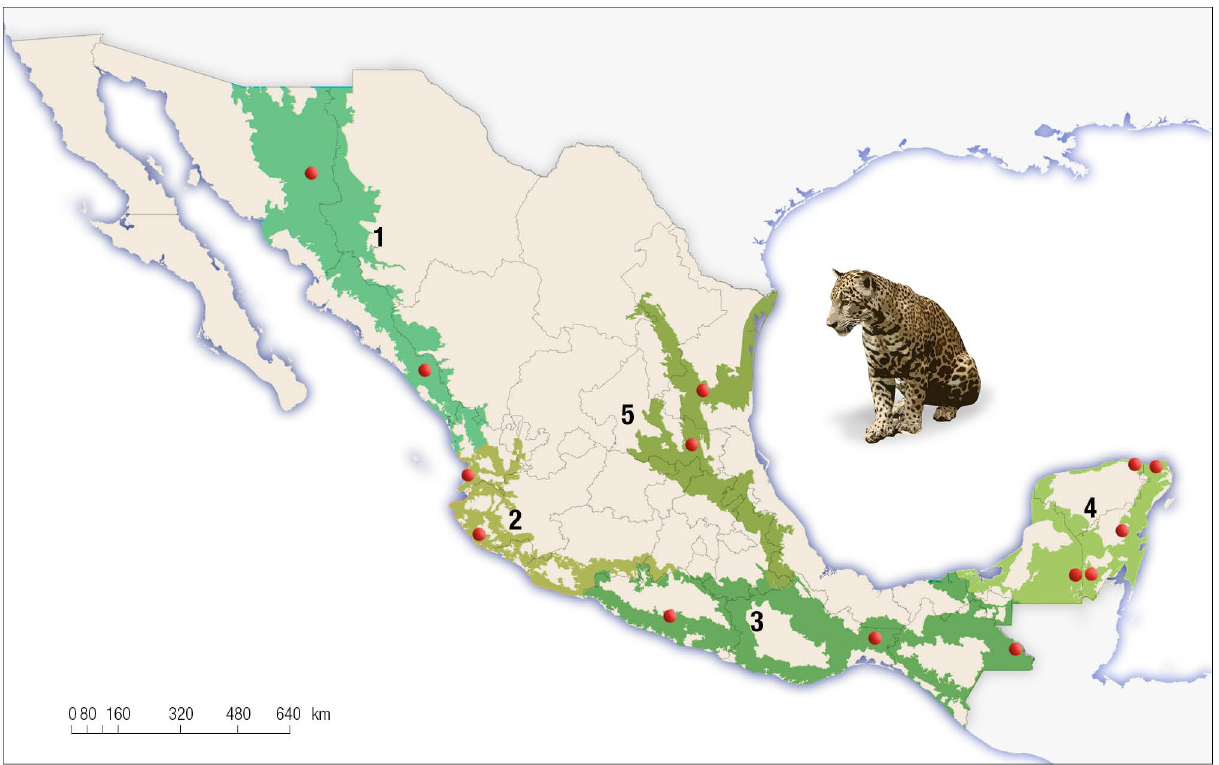
Fig 2. The five jaguar conservation regions include all the current geographic range of the species in Mexico and location study sites from the national jaguar census